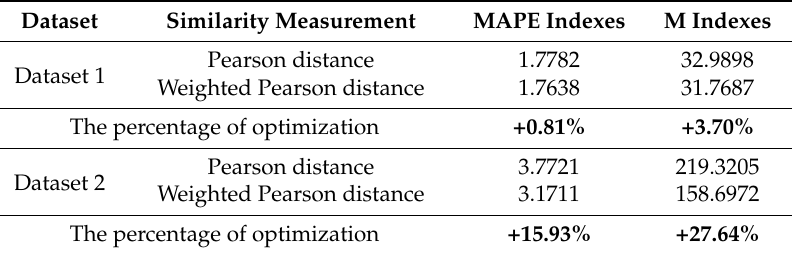
Table 3. The calculation results of short-term load prediction evaluation